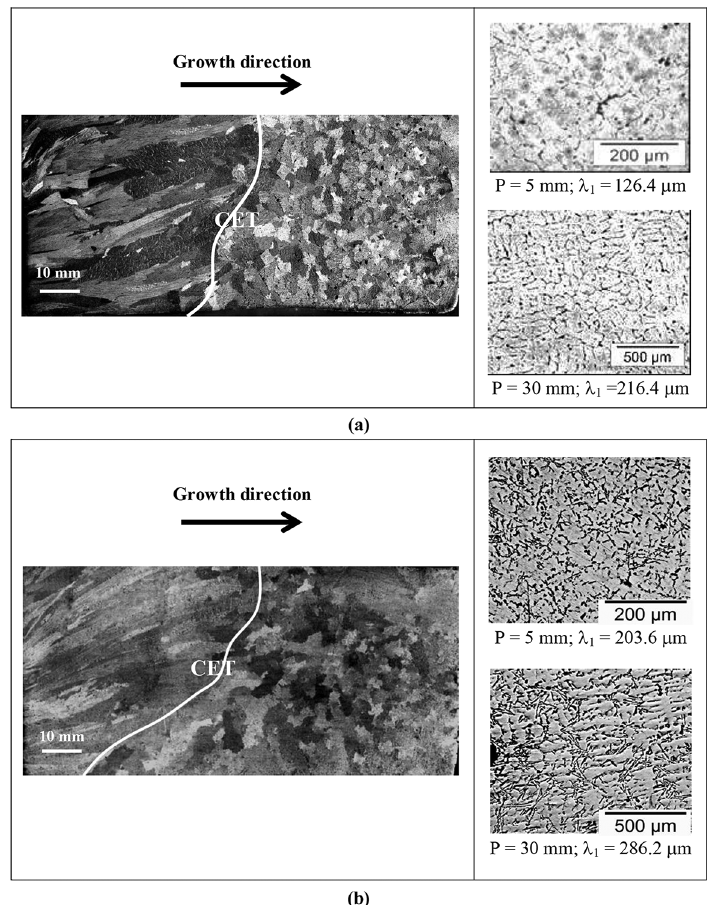
Figure 2 - Solidi fi cation microstructures and macrostructures, CET positions, and corresponding primary spacings: ( a ) Al–6wt.%Cu; ( b ) Al-6wt.%Cu-